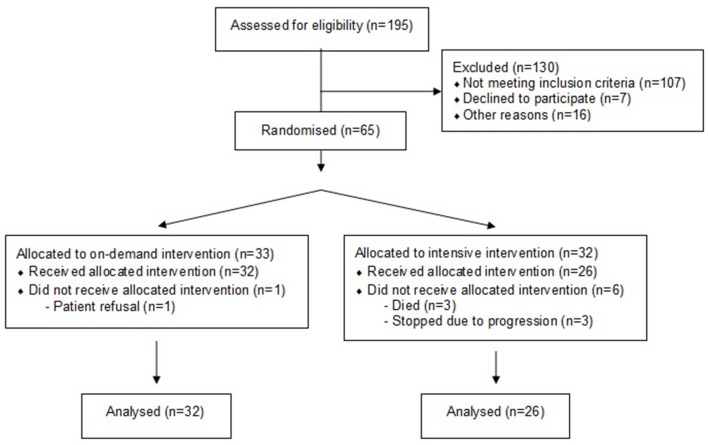
Study flowchart.